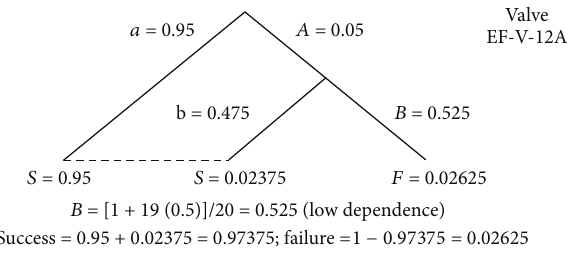
Figure 3: Dependence between teams in Task 𝐵 .